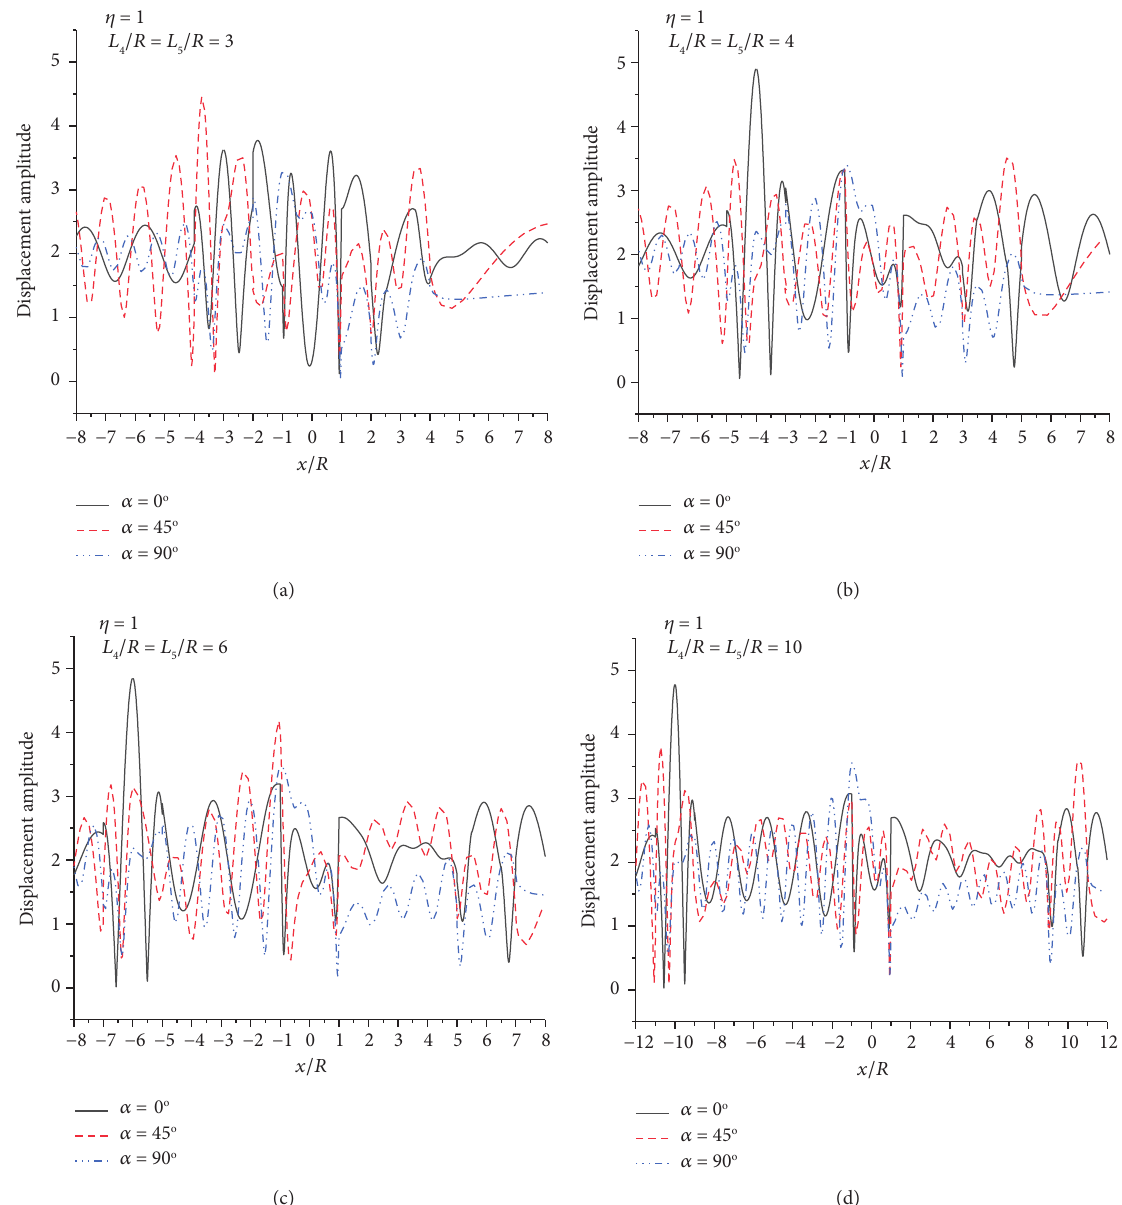
Figure 6: Surface displacement amplitude with the change of L displacement amplitude at L � L � L 4 5